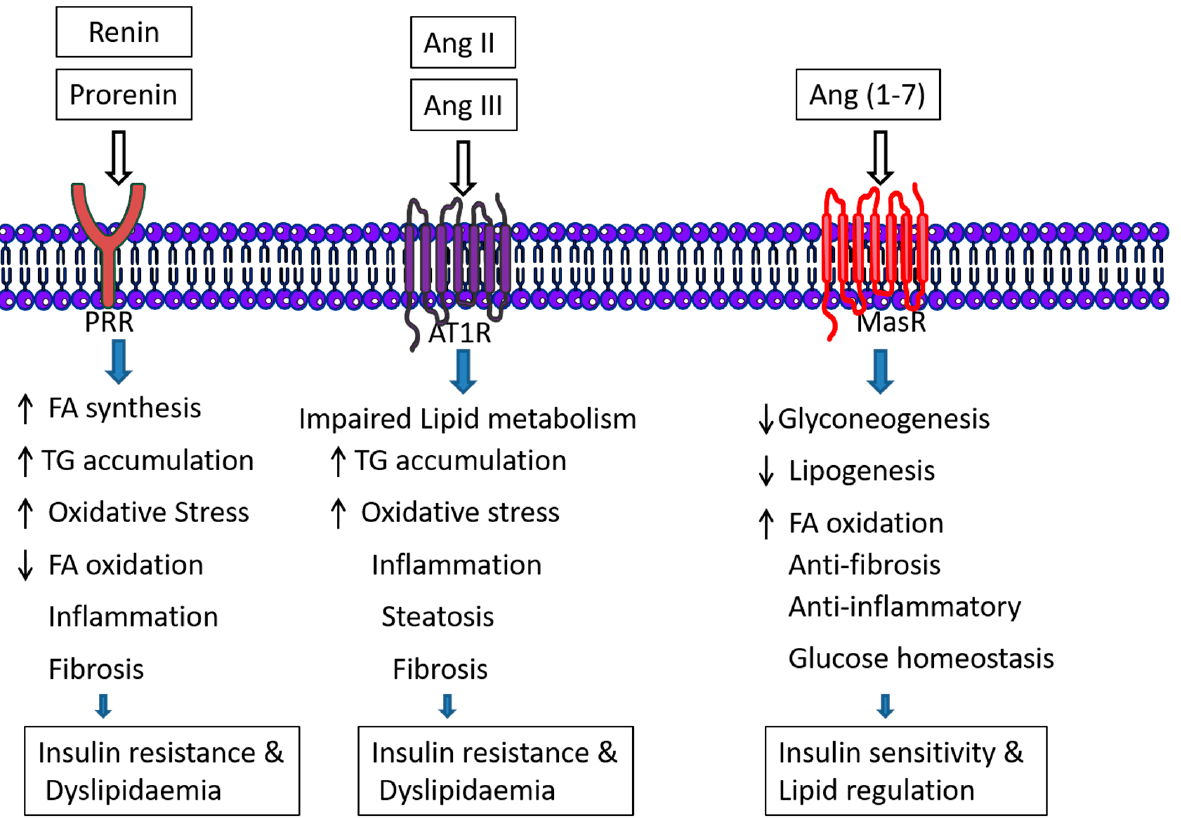
Figure 5. Effect of RAS in lipid and carbohydrate metabolism. Two RAS arms, ACE/AngII/AT1 and ACE2/Ang(1-7)/MasR, act antagonistically on lipid and carbohydrate metabolism. PRR also accelerates the FA synthesis and tricarboxylic acid cycle (TCA).